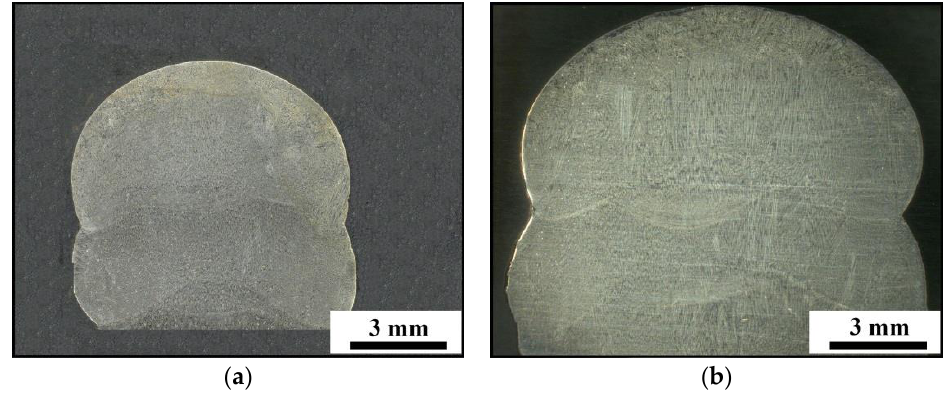
Figure 5. Macro-morphologies of the top region within the AM parts under: ( a ) low LEI; ( b ) high LEI.